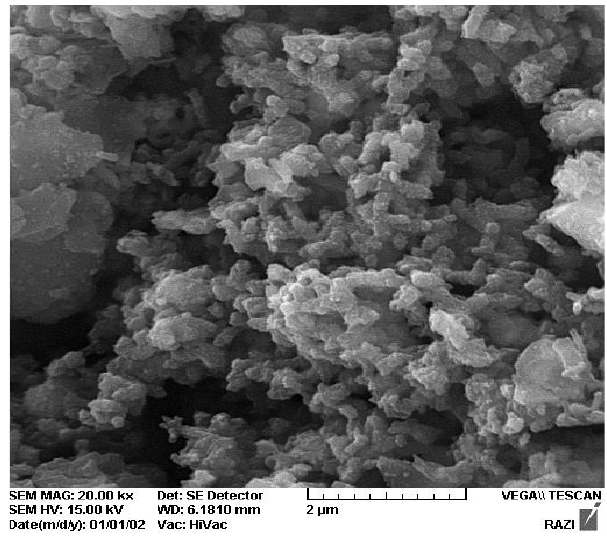
Fig 1. Scanning electron micrograph of PANI generated in aque- ous media. Reaction conditions: (NH 10 -2 mol/L, volume of solution 100 mL.